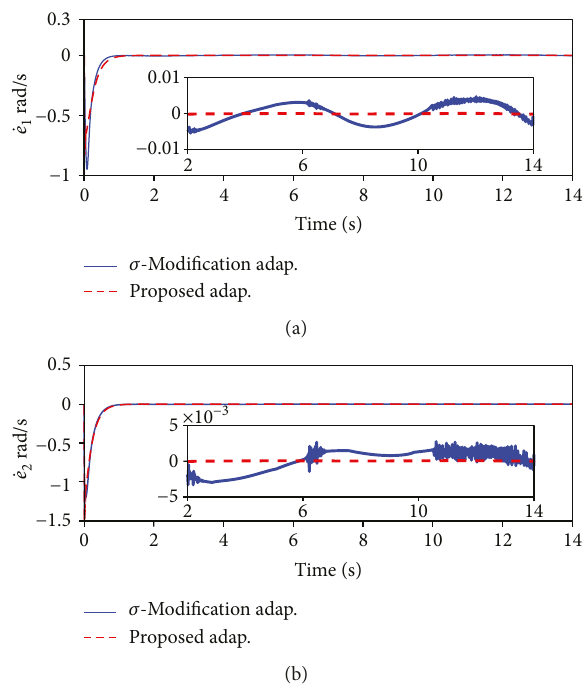
Figure 6: Tracking error of robotic joint velocity q